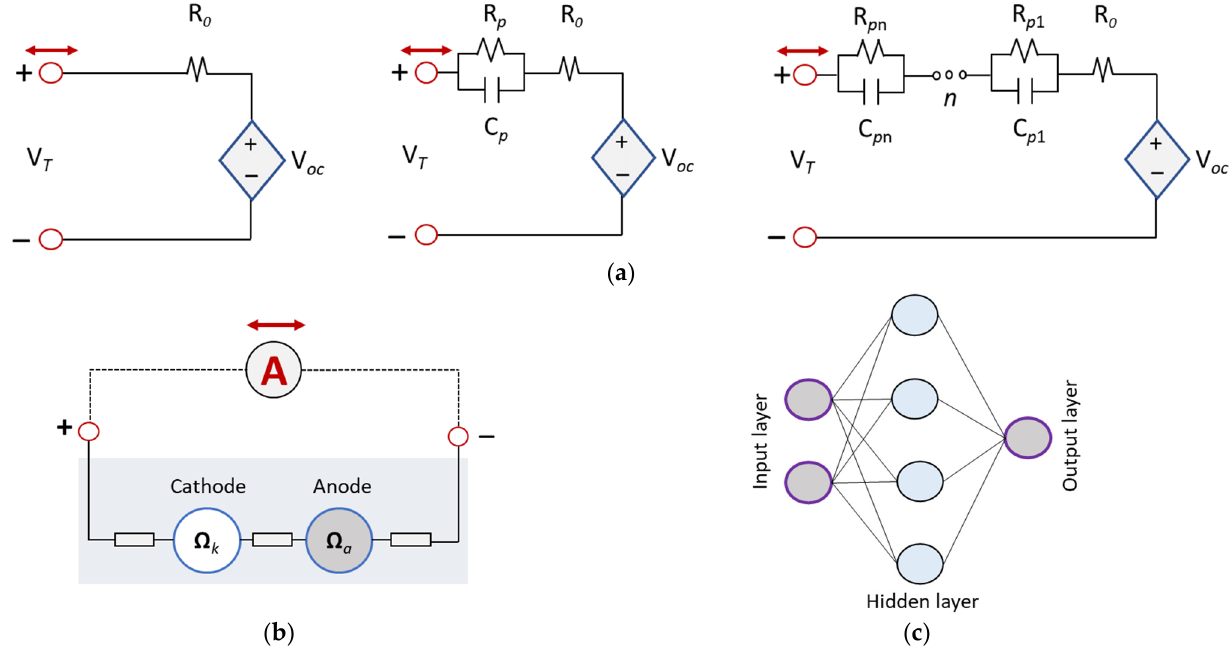
Figure 11. Graphical illustration of battery modeling techniques. ( a ) Electrical equivalent (basic, extended, and generalized). ( b ) Electrochemical. ( c ) Data-driven (neural network).